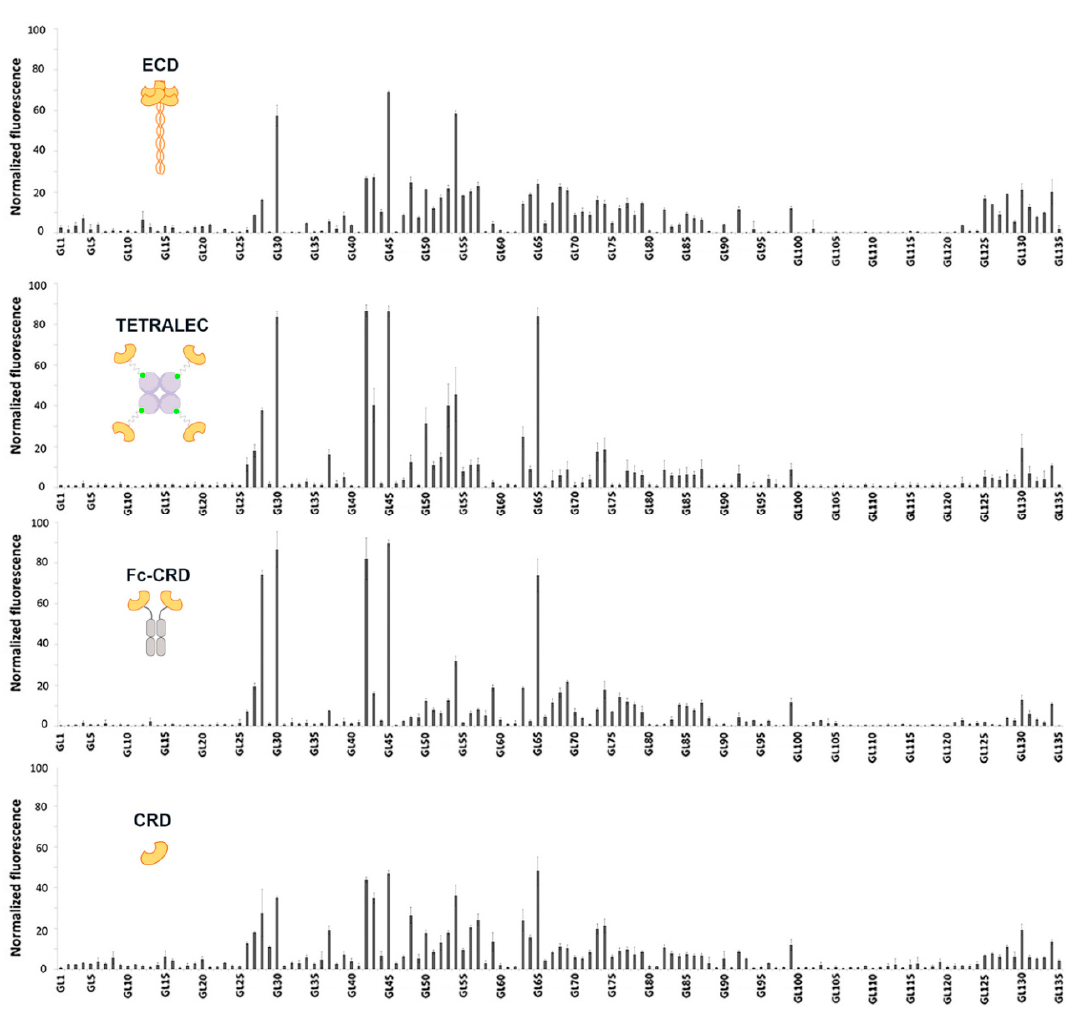
Figure 5. Glycan binding profiles of DC-SIGNR ECD, TETRALEC, Fc-CRD and CRD. Histograms representing the normalized fluorescence values. X-axis has been labeled with glycan numbers in ascending order with only one out of five glycan names mentioned.